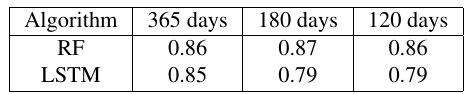
Table 2. Overall Accuracy of LSTM and random forest(RF) classifiers using three different time windows as inputs.